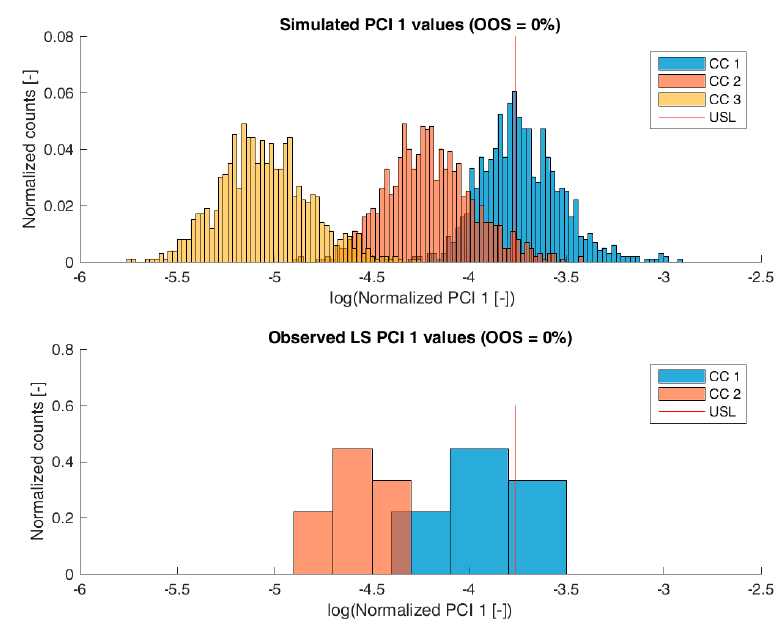
Figure 5. Comparison of simulated ( top ) process-related impurity 1 distribution and observed ( bottom ) process-related impurity 1 from LS after each column step. For chromatography column 3 pool, no process-related impurity 1 value was observed above LoQ, therefore, no histogram bar is plotted for the observed values at chromatography column 3 pool. Normalization was performed by dividing by the maximum observed c CQA .